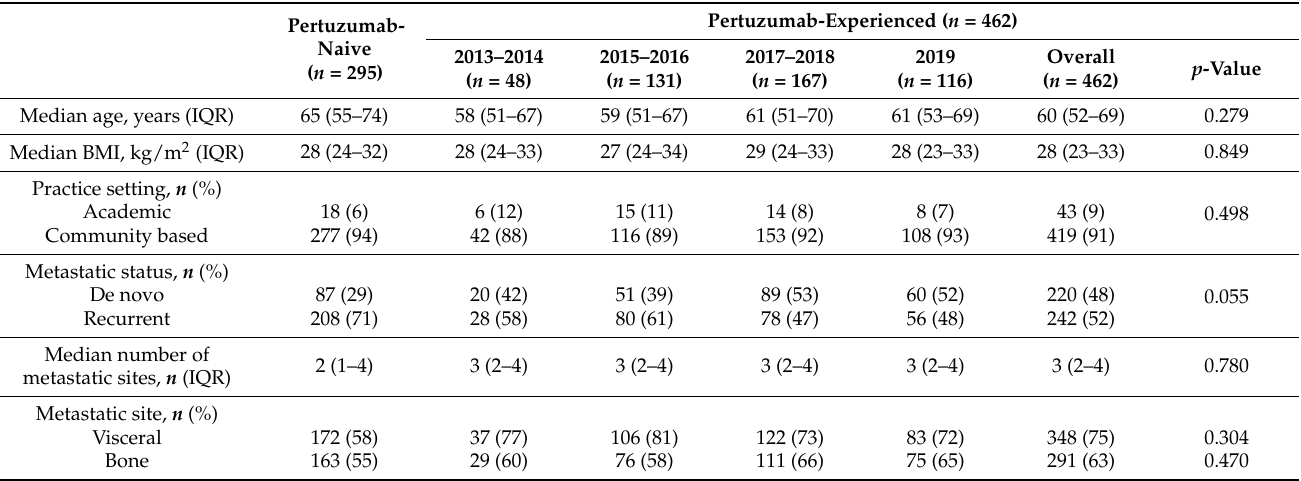
Table A3. Demographic and disease characteristics on the index date a in the primary cohort